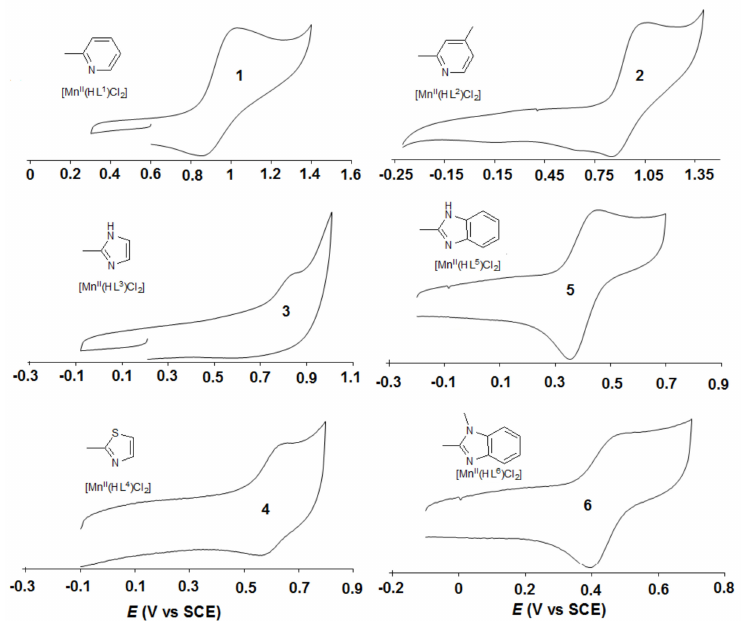
Figure 2. Cyclic voltammetry of the [Mn II (HL n )Cl 2 ] (HL = 1,3-bis(2’-Ar-imino)isoindoline; Ar = pyridyl (n = 1), 4-methylpyridyl (n = 2), imidazolyl (n = 3), thiazolyl (n = 4), benzimidazolyl (n = 5) and N -methylbenzimidazolyl (n = 6)) complexes in DMF at 25 ◦ C.